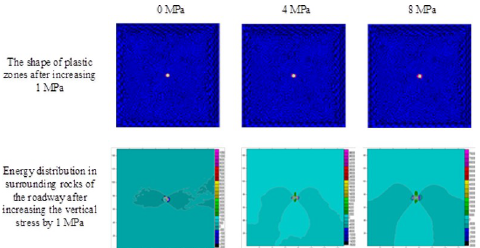
Fig 8. The shape of the plastic zone and the energy distribution of the surrounding rock of the roadway after the vertical stress increases by 1 MPa under different abutment pressures (0–8 MPa).